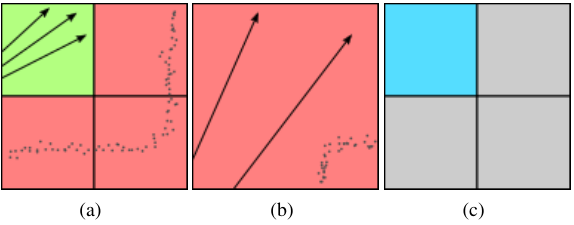
Figure 1. (a) A quadtree with free (green) and occupied (red) cells. (b) The same area, after parts of the surface have been removed. Only a few rays traverse the cell, therefore it is falsely classified as occupied. (c) A quadtree representing changed (blue) and unchanged (grey) areas, showing that all cells are classified